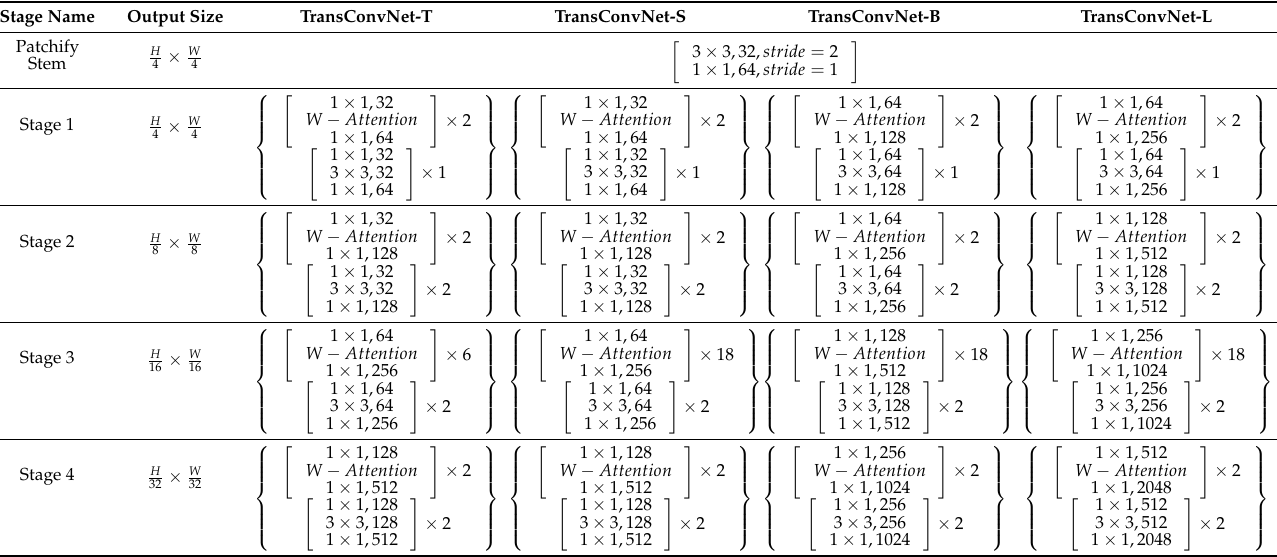
Table 1. The structure of the backbone network with different scales. Building blocks are shown in brackets, with the numbers of blocks stacked. Downsampling is performed in first 3 × 3 convolution in each stage.